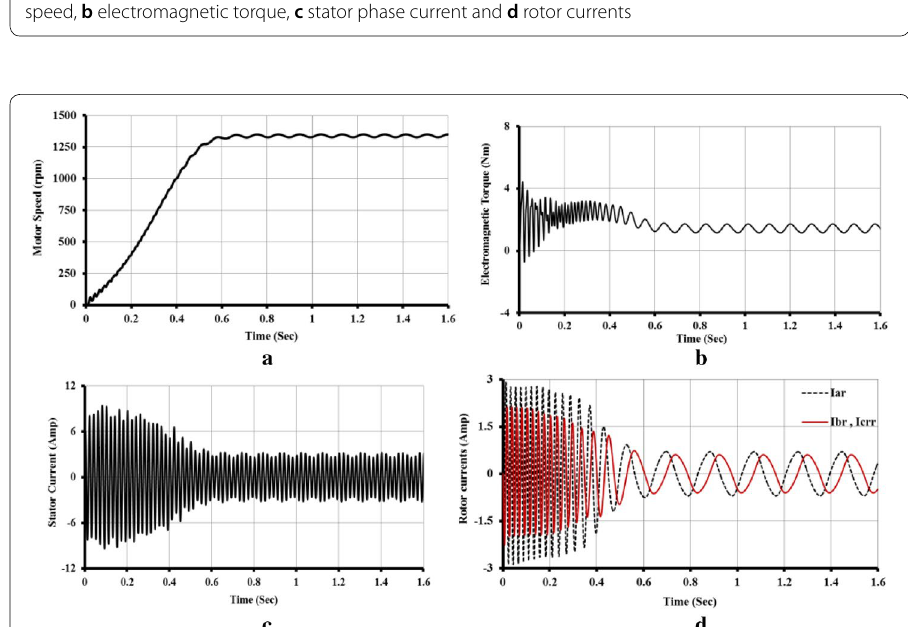
Fig. 5 Motor performance for delta with reversed one phase and external open circuit rotor windings connection, a motor speed, b electromagnetic torque, c stator phase current and d rotor